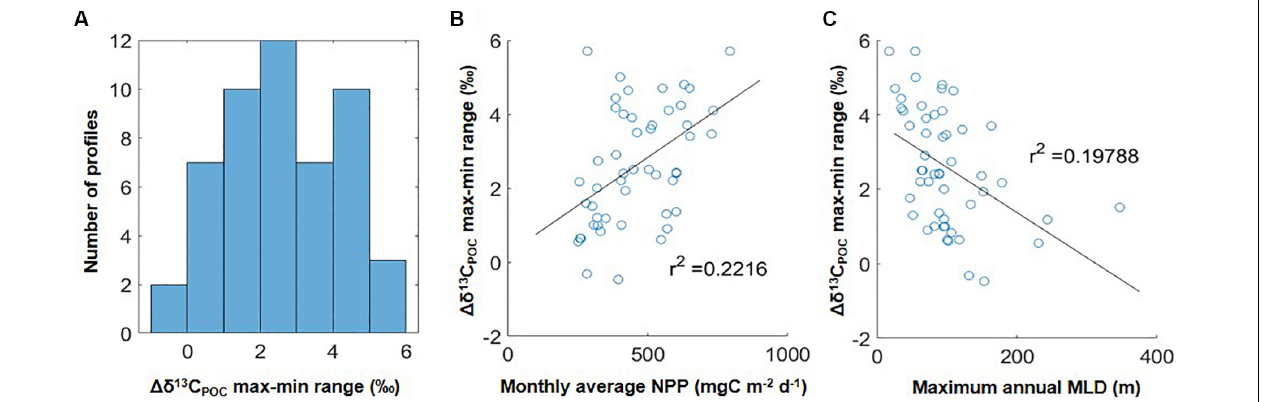
FIGURE 2 | (A) Distribution of upper water column ranges in (cid:49) δ 13 C POC values in the 51 individual water columns in this study, calculated as the overlying maximum δ 13 C δ 13 C POC value minus subsurface minimum POC value (i.e., maximum values occurring at depths below the minimum are not considered here). Negative values indicate profiles in which the minimum δ 13 C POC value was found at the shallowest data point. (B) Comparison of (cid:49) δ 13 C POC max-min ranges in (A) to climatological net primary production (NPP) at each location. (C) Comparison of (cid:49) δ 13 C POC max-min ranges in (A) to maximum annual mixed layer depth (MLD max ) at each location. One extreme outlier was omitted from (B) with an NPP value of 1250 mg m − 2 d − 1 and (cid:49) δ 13 C POC max-min range of 1.8 (cid:104)